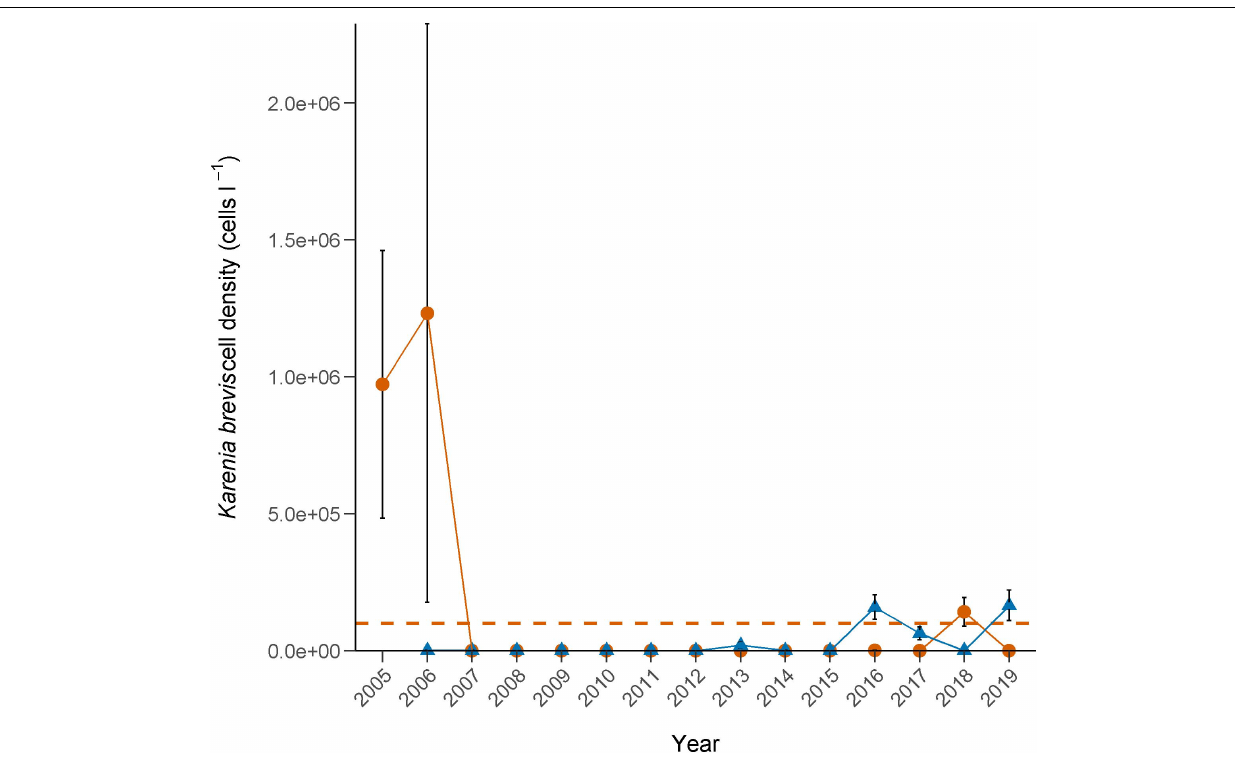
FIGURE 6 | Annual Karenia brevis cell densities (mean ± se) measured at each fish sampling station in the Sarasota Bay study area during 2005–2019. Symbols: • = summer months, (April–September); (cid:78) = preceding winter months, (October–March). Horizontal dashed line = 100,000 cells l − 1 threshold for ichthyotoxic